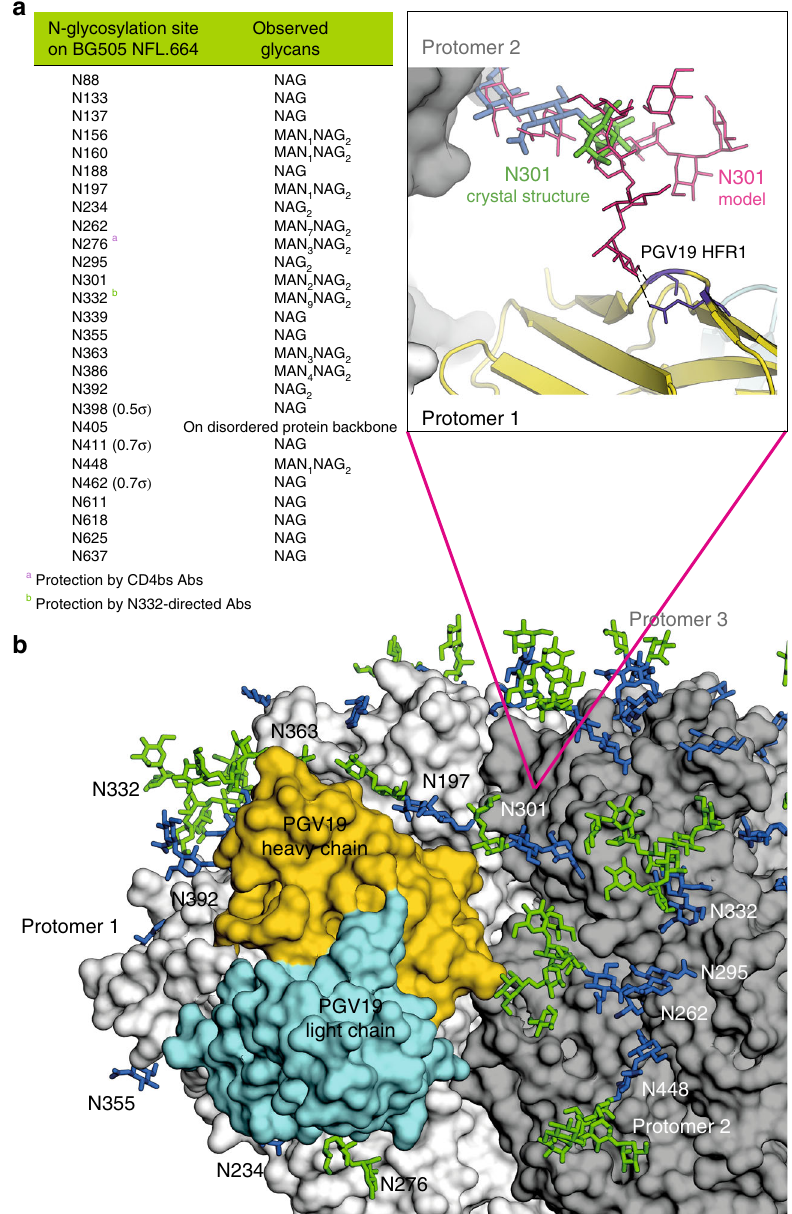
Fig. 6 Glycosylation on the NFL Env trimer and glycan fence around the CD4bs. a Glycosylation observed in the BG505 NFL.664 structure (with at least 0.8 – 1.0 σ electron density). Glycans that are observed at less than 0.8 σ have not been included for calculating observed moieties per sequon or modeled on the structure, but are included in parentheses in a . b Surface representation of BG505 NFL.664 (protomers 1 – 3 shown in shades of gray) with the PGV19 variable region (HC: yellow, LC: cyan) and the N-glycosylation observed in the crystal structure ( N -acetyl-glucosamine in blue and mannose in green). The glycan fence is formed by N197, N363, N234, and N276 on the same protomer, along with N301, N295, and N262 on the adjacent protomer of the Env trimer that the CD4bs Abs have to circumnavigate to access their epitope. The zoomed-in panel illustrates the modeled interaction of Man 9 at N301 with the heavy chain framework 1 (HFR1) of